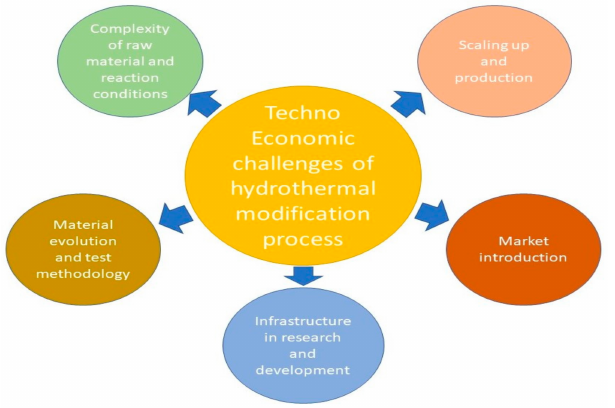
Figure 3. Challenges in technologies for the hydrothermal modification of wood for practical applications (summarized from Militz and Lande